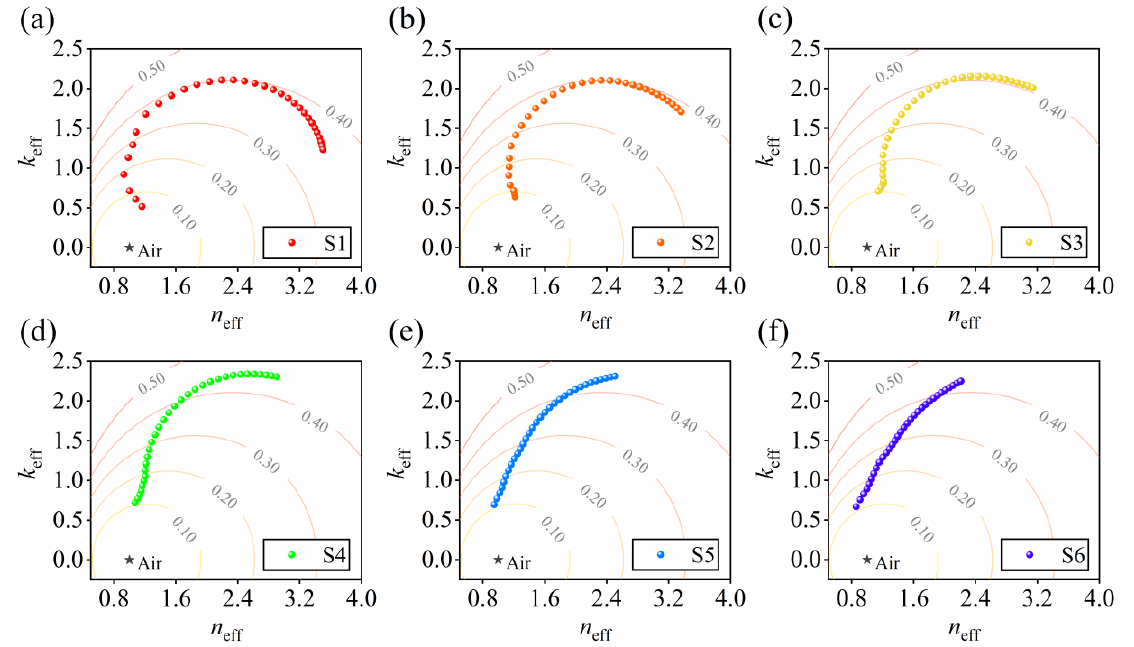
Figure 2. Trajectories of the optical admittance of ( a ) S1, ( b ) S2, ( c ) S3, ( d ) S4, ( e ) S5 and ( f ) S6 in 210–1000 nm. Points near the origin correspond to short wavelengths. Light lines represent the contour lines of reflectance. The black star indicates the admittance of air.